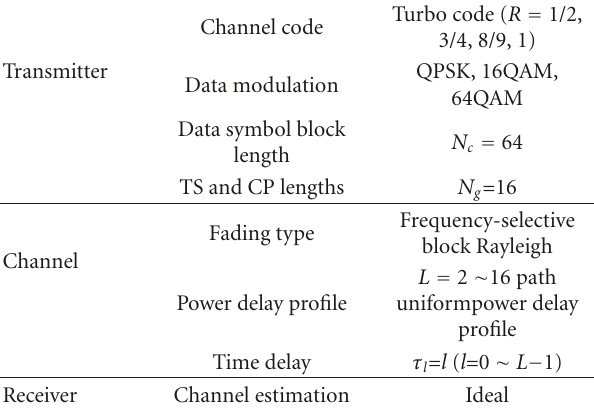
Table 1: Computer simulation